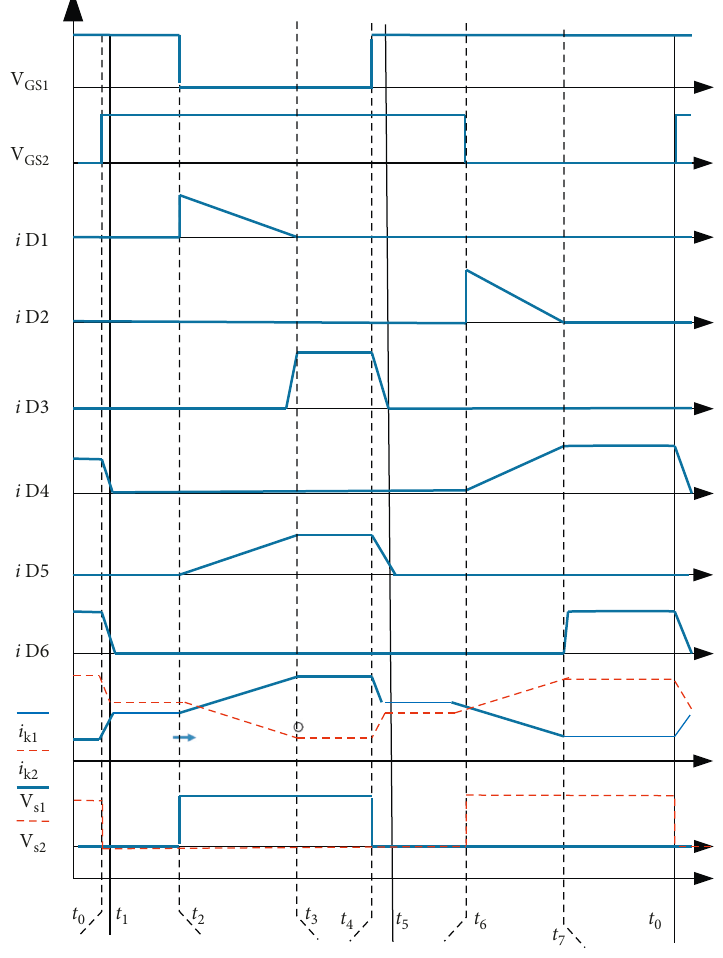
Figure 3: Key waveforms in CCM